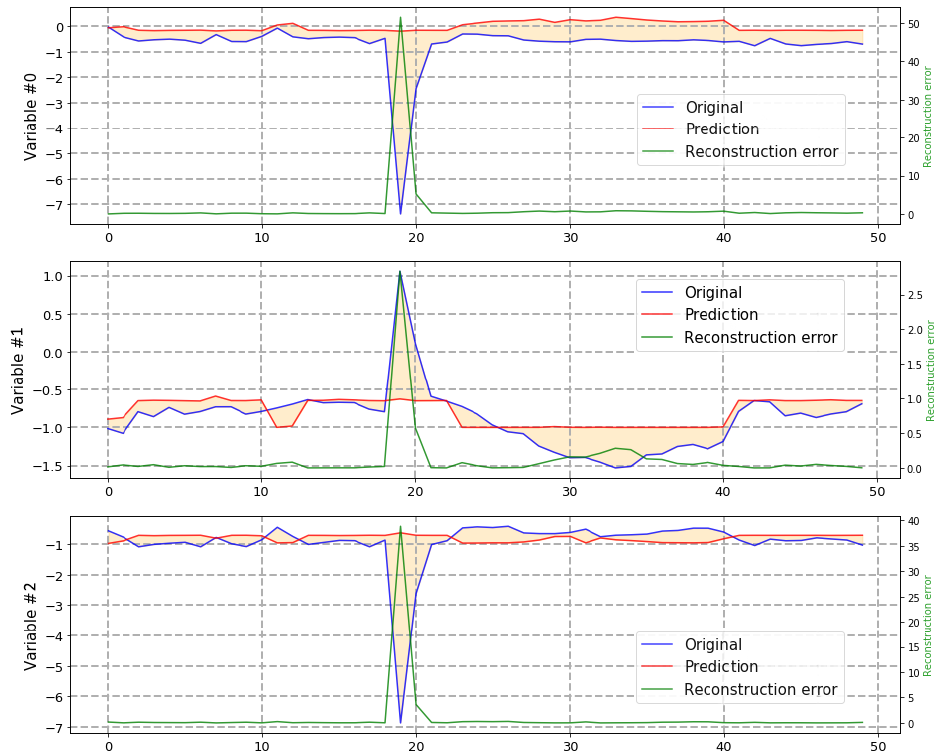
Figure 2. Autoencoder output (red) versus the original value to be reconstructed (blue) and the associated reconstruction error (green) for three attributes of the diesel engine for propulsion. x -axis represents normalized data coming from a BAM-class (Maritime Action Vessels) ship; y -axis contains an ordered index. Reconstruction error rises when the autoencoder is unable to reproduce the